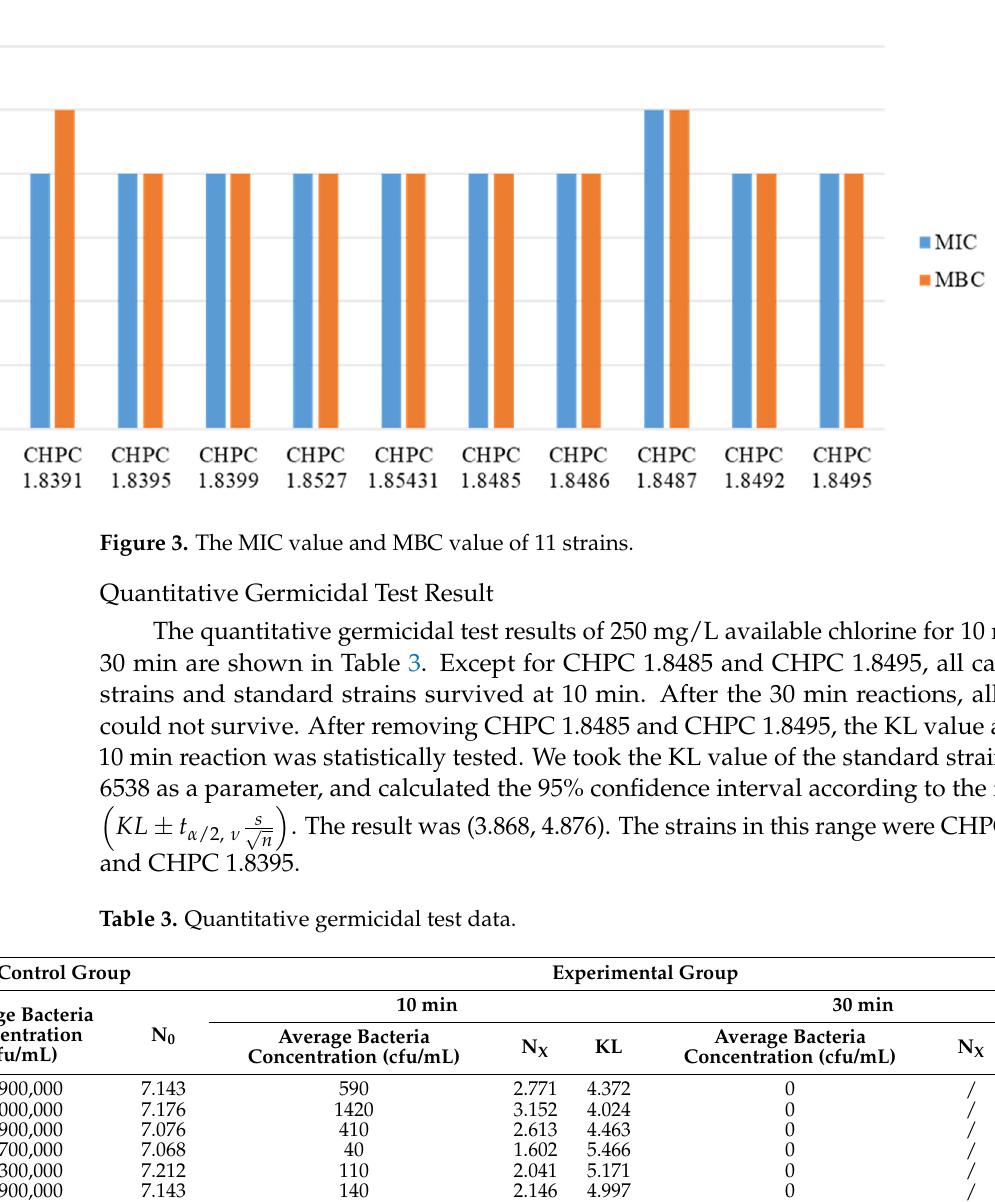
8 of 16 Table 2. Neutralizer test results No.